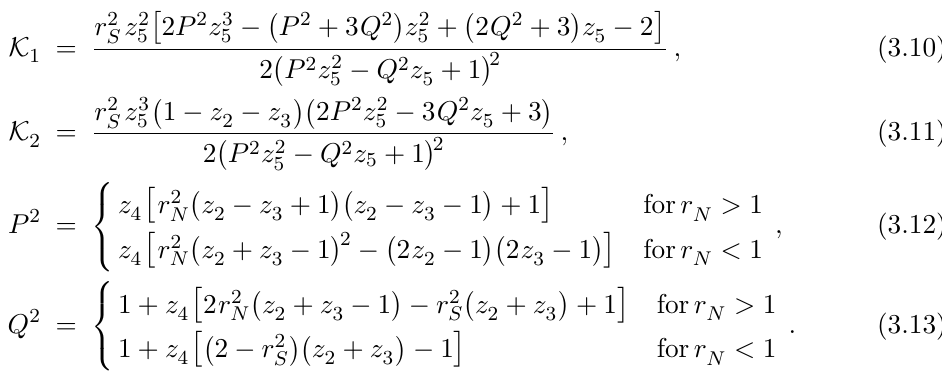
. As indicated, the S